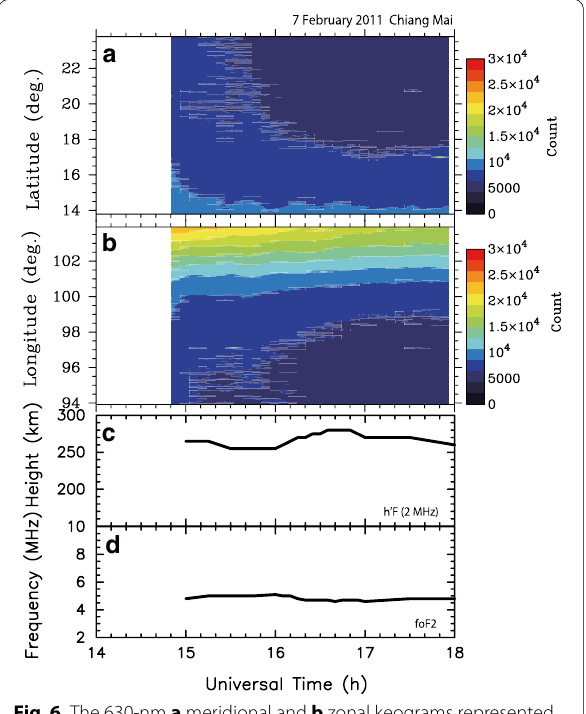
Fig. 6 The 630-nm a meridional and b zonal keograms represented as raw CCD counts, c h ′ F and d f o F 2 observed by an ionosonde,